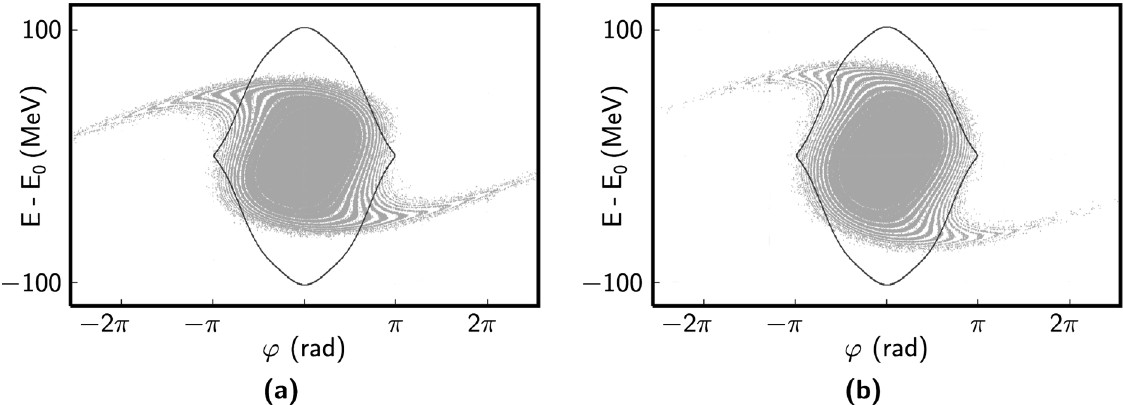
FIG. 4. Simulated bunch shapes at injection into the SPS bucket: (a) under operational conditions ( V 40 MHz ¼ 300 kV and V 80 MHz ¼ ¼ 600 kV and V ¼ 600 kV with optimal rotation timings. Simulations used 600 kV ); (b) using rotation voltages of V 40 MHz 80 MHz